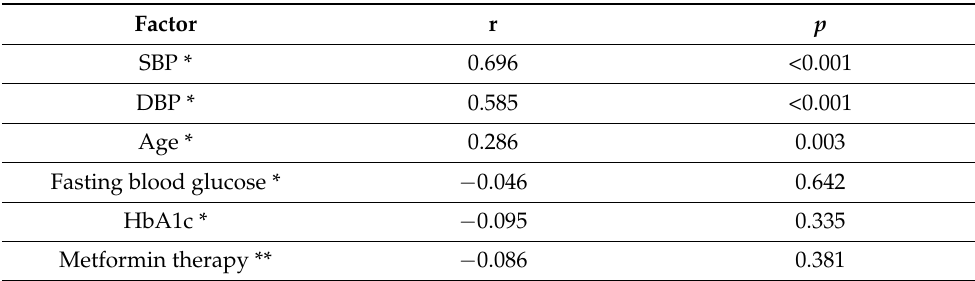
Table 4. Correlation between plasma total homocysteine concentration with some clinical and biochemical